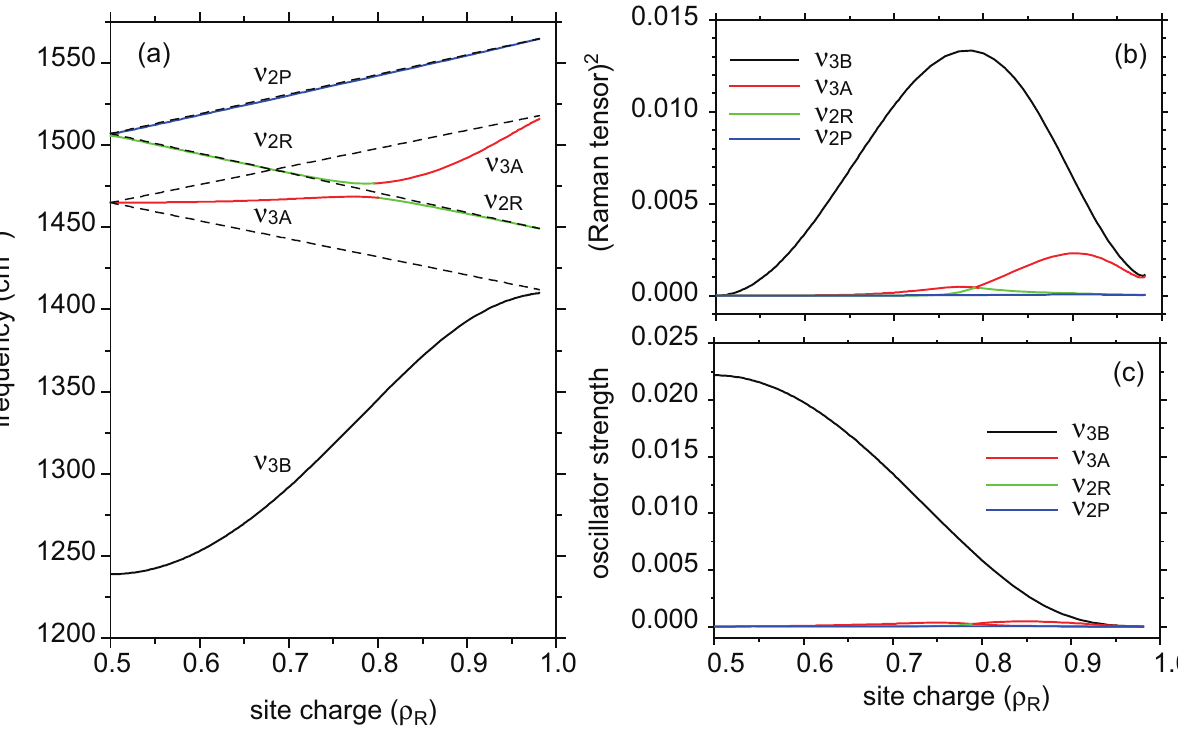
Figure 2. ( a ) Frequency of the vibronic modes plotted against the site charge of charge- + ρ = 1). The transfer integral is t = 0.2 eV, EMV coupling constants for ν rich site ( ρ P R 2 and ν are g = 0.02 eV and g = 0.1 eV, respectively. The dashed line shows the site- 3 2 3 charge dependence when g = g = 0, assuming a linear relationship against site charge ρ . 2 3 The frequencies at ρ = 0 and 1 are ν (0) = 1567 cm − 1 , ν (1) = 1447 cm − 1 , ν (0) = 1520 cm − 1 , 2 2 3 and ν (1) = 1410 cm − 1 ; ( b ) Contribution of the intermolecular excitation to the Raman 3 tensor of the vibronic modes, which are plotted against the site charge of the charge-rich site; ( c ) Oscillator strength of the vibronic modes plotted against the site charge of the charge-rich